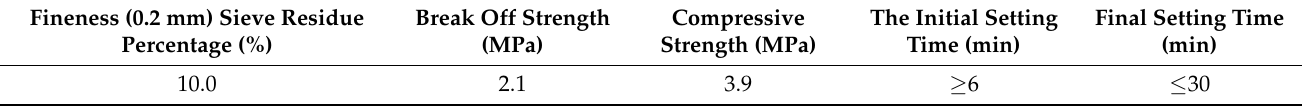
Table 1. Performance parameter table of gypsum.